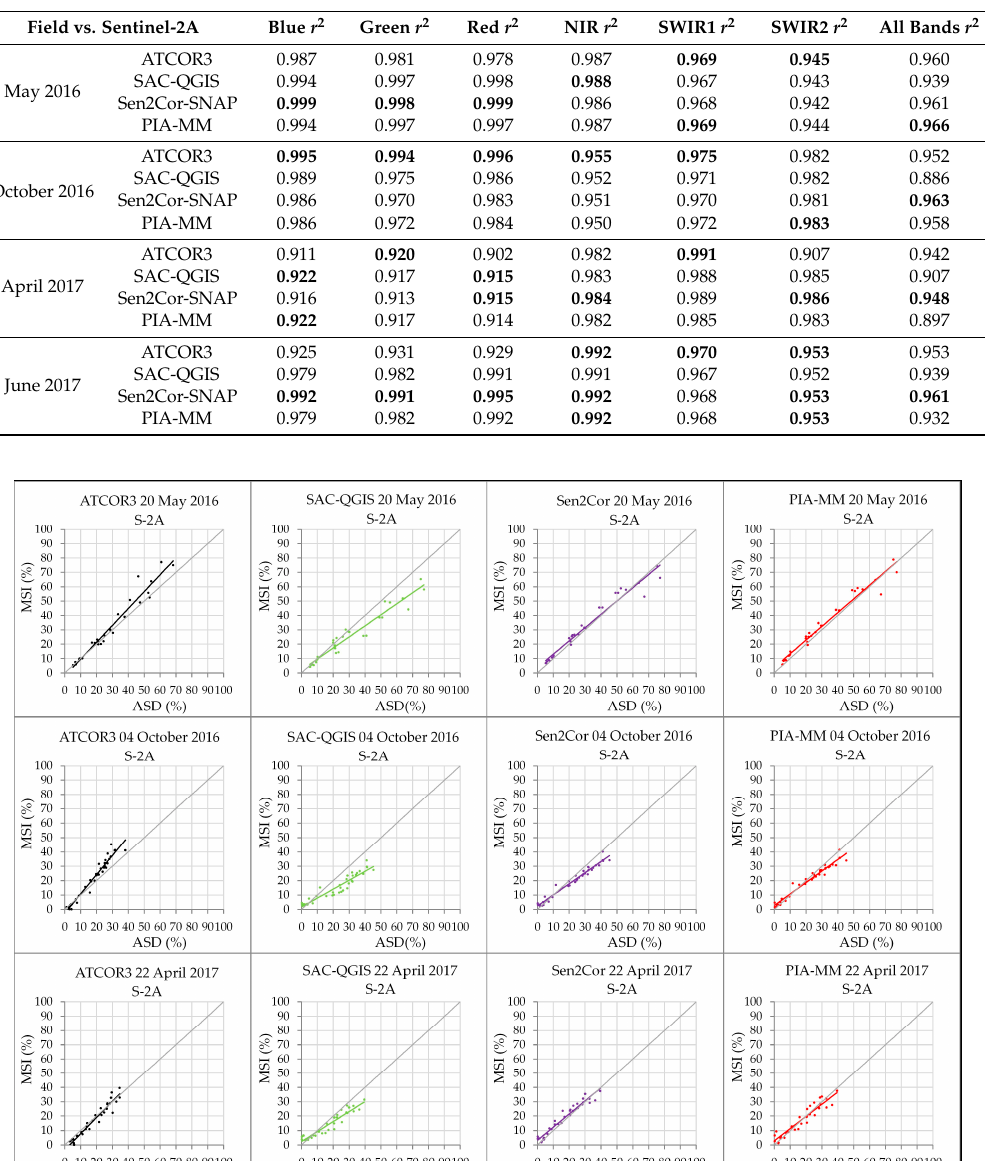
Table 5. Band-by-band coefficient of determination ( r 2 ) between field spectroradiometry values and atmospheric corrections for Sentinel-2A (MSI) imagery. Best values in bold.